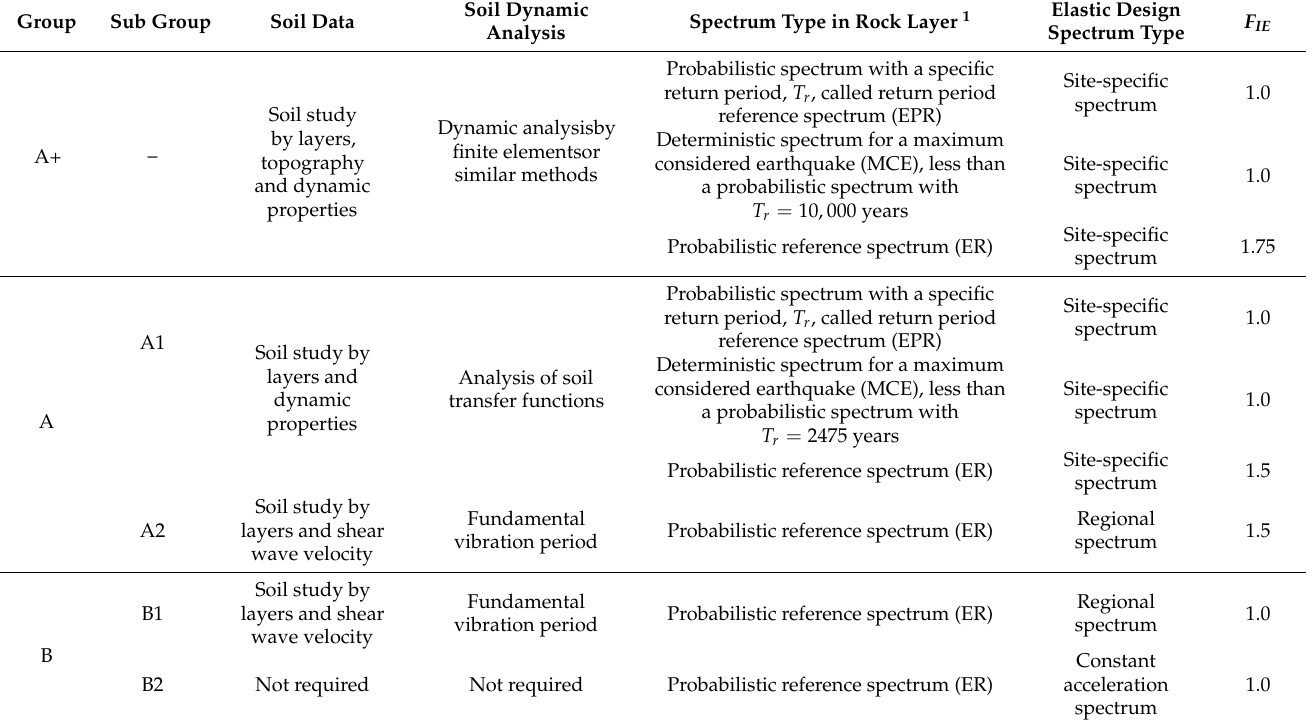
Table 3. Spectra types, importance factors, and soil properties for each group and subgroup, adapted with permission from Ulises Mena, Comisi ó n Federal de Electricidad Manual de Diseño de Obras Civiles; published by Comision Federal de Electricidad (CFE), 2015